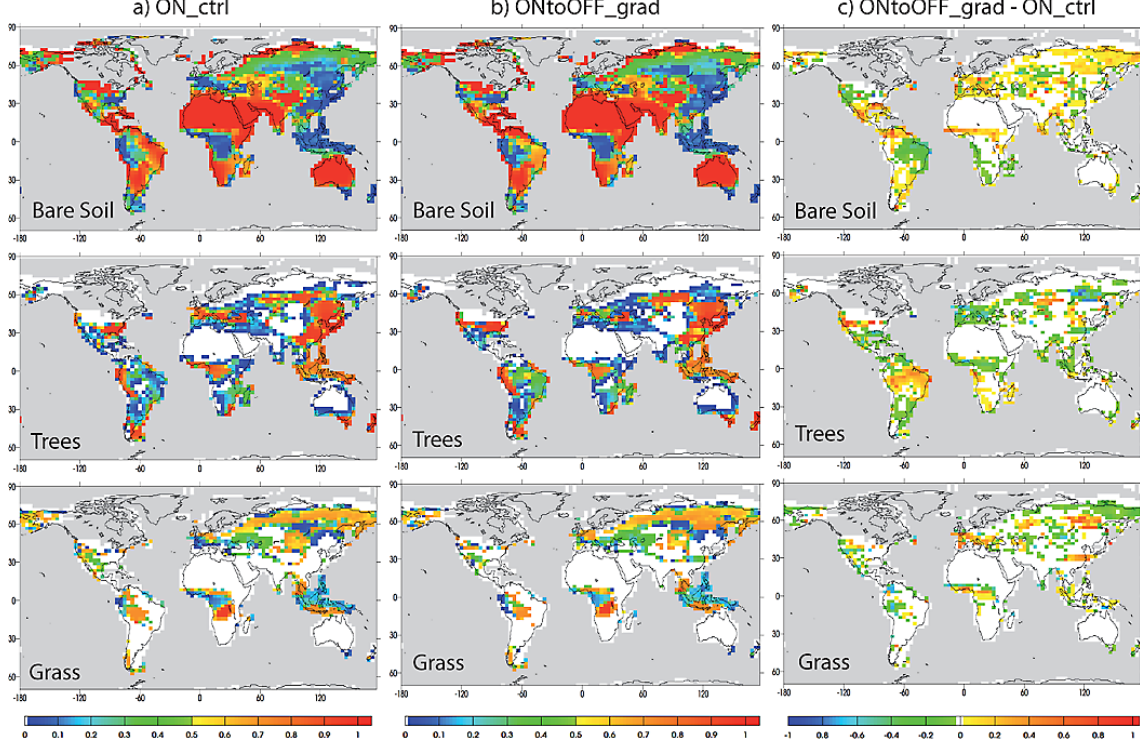
Fig. 3. Fractions of bare soil, trees and grass (between 0 and 1) simulated by ORCHIDEE in (a) ON ctrl (average over 500yr of run), (b) ONtoOFF grad (average over the last 200yr of run) and (c) differences between ONtoOFF grad and ON